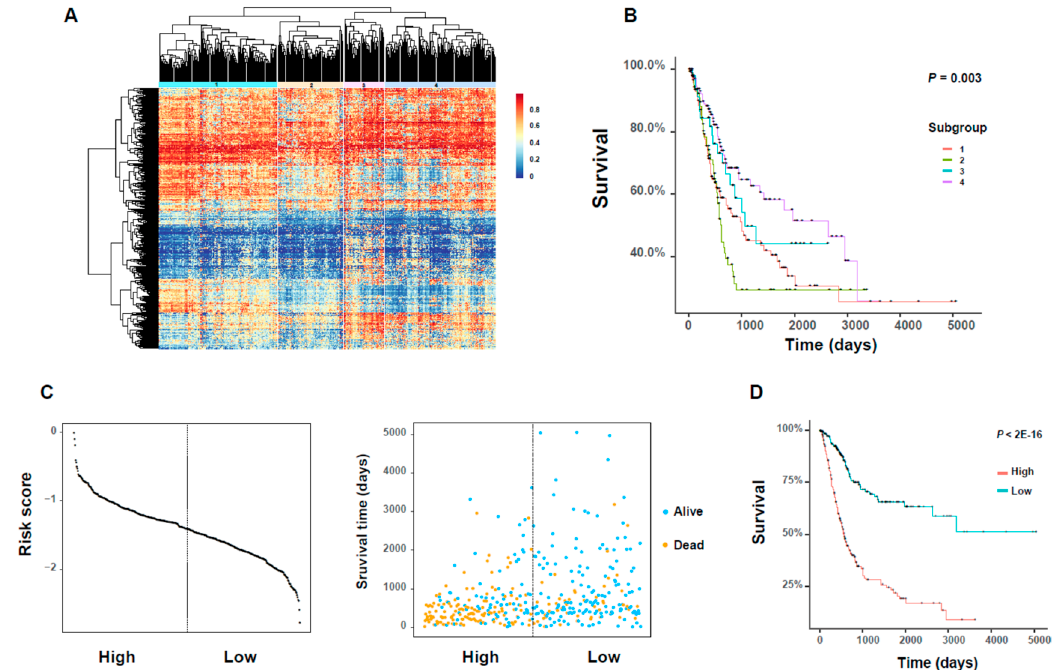
Figure 6. The analysis of DNA methylation profiles related to clinical prognosis of BLCA patients. ( A ) The heatmap of hierarchy clustering based on the beta values of 340 active DNA methylation probes. The rows stand for the 340 probes and the columns stand for the 404 BLCA patients. ( B ) The Kaplan–Meier plot showing the di ff erence in overall survival rates between individual subgroups. ( C ) The distribution of the 26 gene-based risk scores (which were defined based on the 26 selected DNA methylation probes) in high- and low-risk groups (left) and the corresponding clinical characteristics of patients (right). The dotted line shows the cutoff value of the risk score. ( D ) The Kaplan–Meier survival plot of the divided high- and low-risk groups and the statistical difference between two groups of patients which was detected by log–rank test.